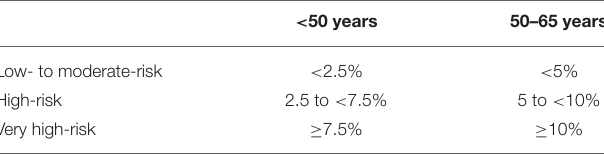
TABLE 2 | Age-dependent risk stratification based on the SCORE 2 protocol